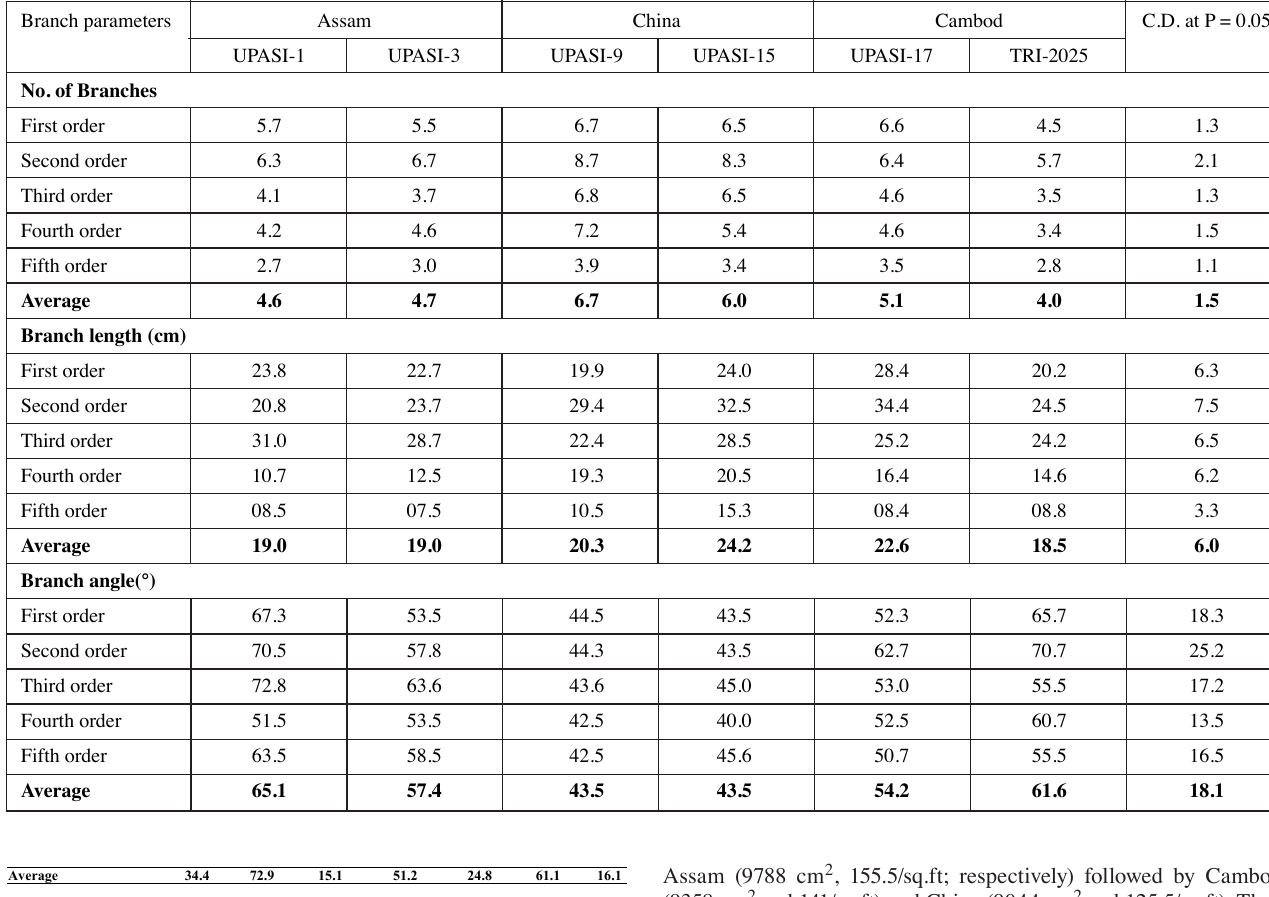
Tab. 2: Branching pattern parameters of various tea clones